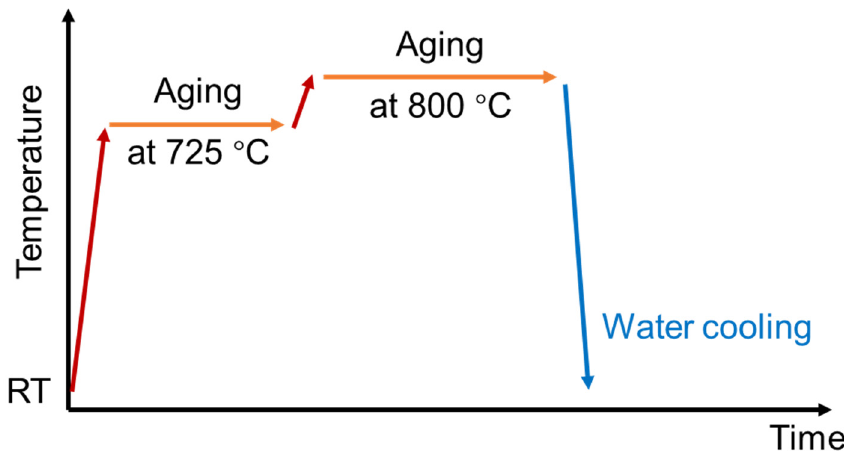
Figure 1. Schematic diagram of the double-aging treatment on the 945A Ni-based